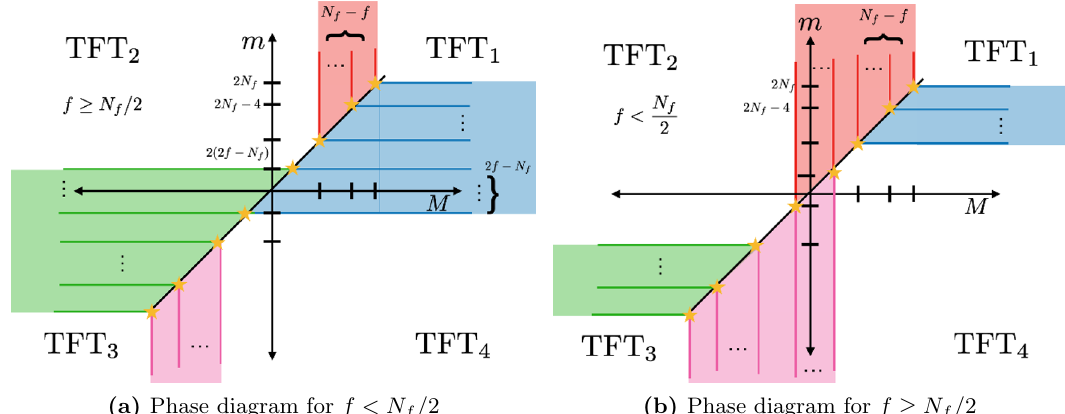
Figure 4. Phase diagrams for QCD 3 with an explicitly broken (cid:13)avor symmetry. The various TFTs shown are SU ( N ) Chern-Simons gauge theory with level k + 1 shaded regions represent the Grassmannians as explained in eq.